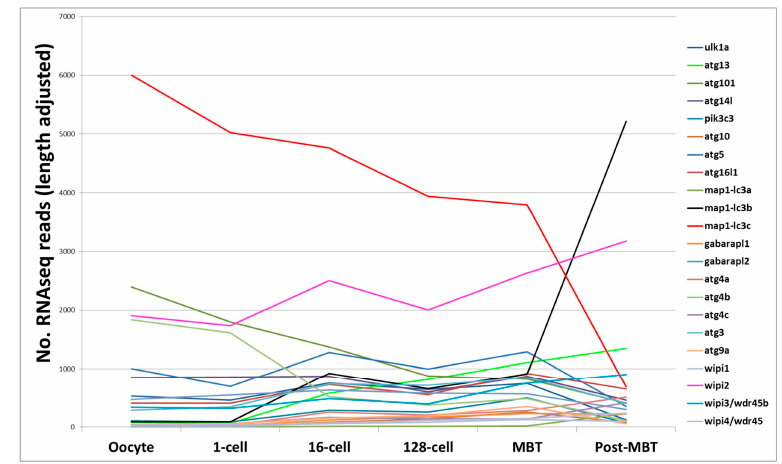
Figure 2. Messenger RNA sequence (mRNA-seq) analysis. Line plot of core autophagy gene transcripts analyzed by mRNA-seq in zebrafish embryos from the oocyte stage to post-mid blastula stage transition.